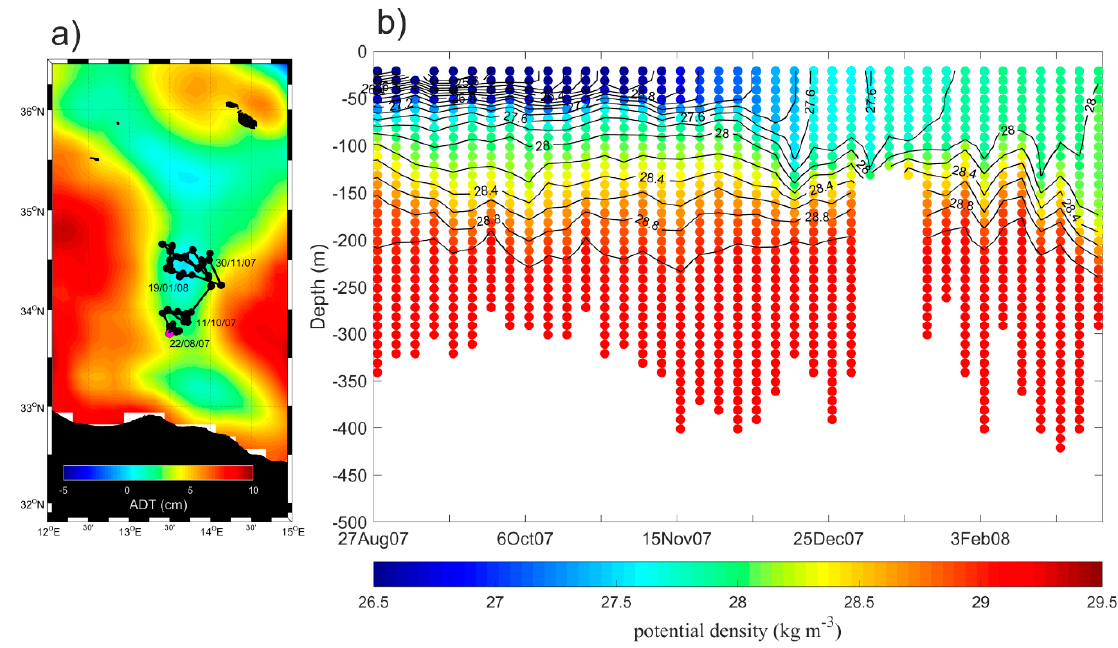
Figure 13. Map of the trajectory (black line) and profile positions (First profile: Magenta dot; Other profiles: Black dots) of the float WMO 1900629, superimposed on the mean map of the ADT (between 27 August 2007 and 23 February 2008) ( a ) and contour diagram of the potential density versus depth and time ( b ).